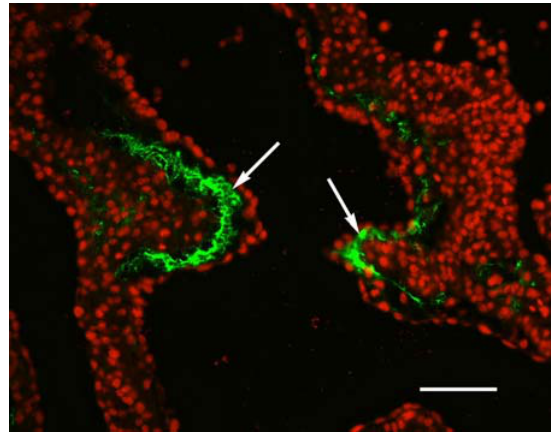
FIGURE 5. Flectin (green fluorescence; see arrows) is evident in the ECM at HH stage 17 in the sinus venosus region of the chick heart where a narrowing of the heart tube is observed. This is a region where a high shear stress of blood flow would be expected. Magnification bar = 50 um.